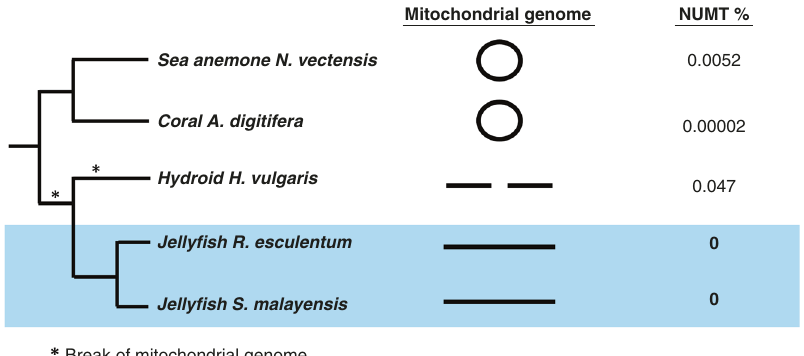
Fig. 3 Mitochondrial genomes in cnidarians. Diagram relating mitochondrial genome conformation to presence of nuclear copies of mitochondrial DNA (NUMTs) in cnidarian genomes. The situation in jelly fi sh genomes implies that linear plastid genomes are not necessarily prone to nuclear integration.